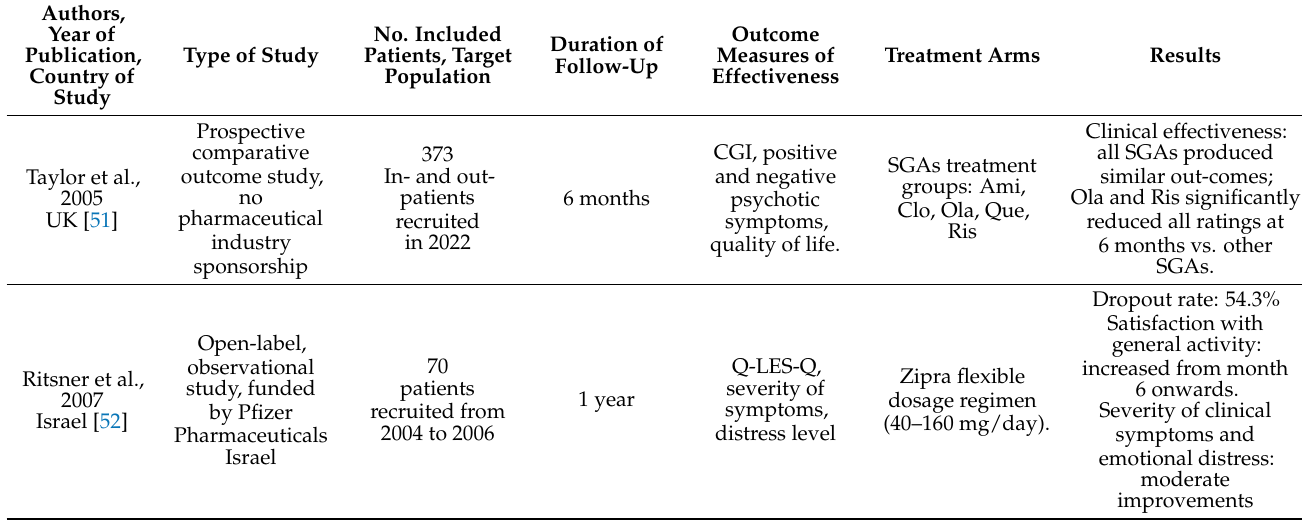
Table 1. Real-world population-based studies investigating the effectiveness of oral SGAs in patients with schizophrenia and related